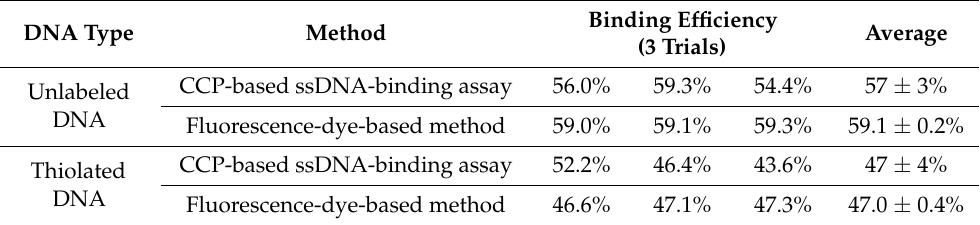
Table 1. The binding efficiency of ssDNA on